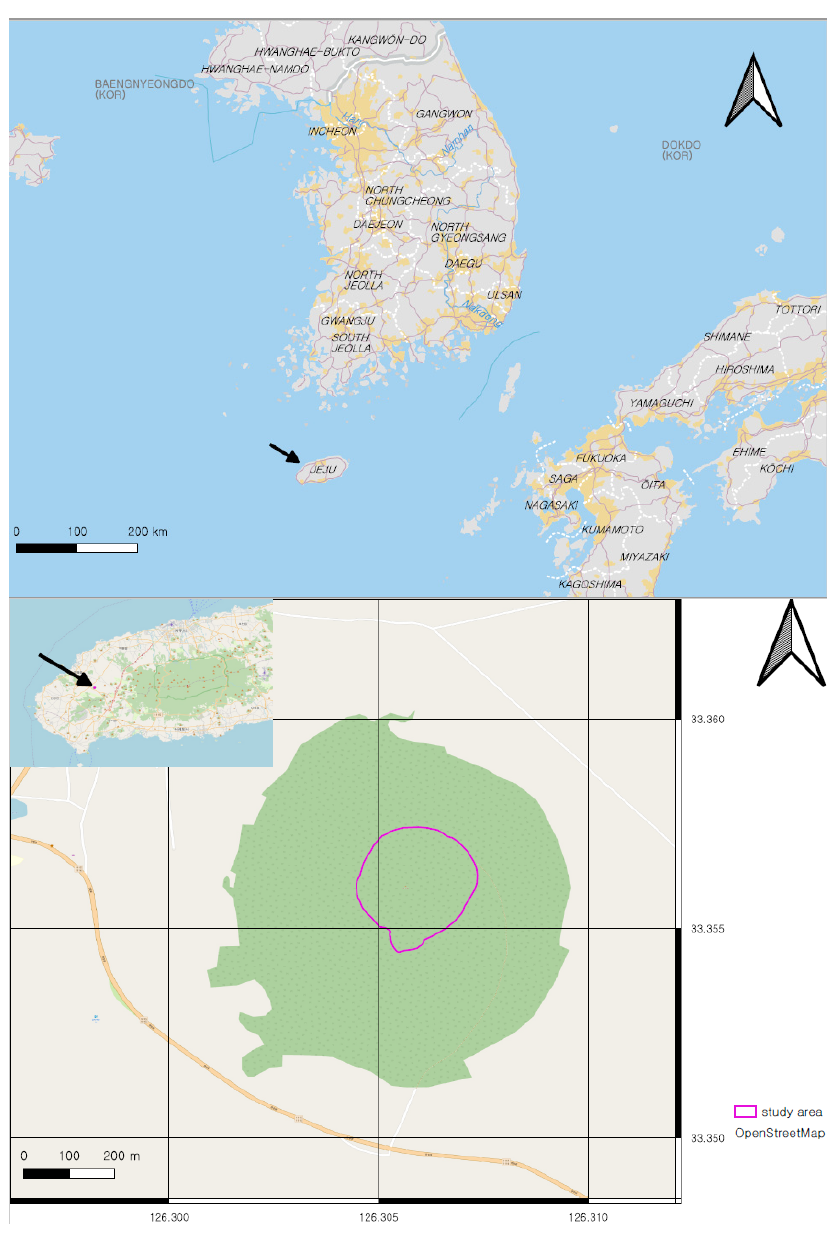
Figure 1. Map of Geum-oreum, Jeju Island, Korea. Its maximum height is about 428 m.